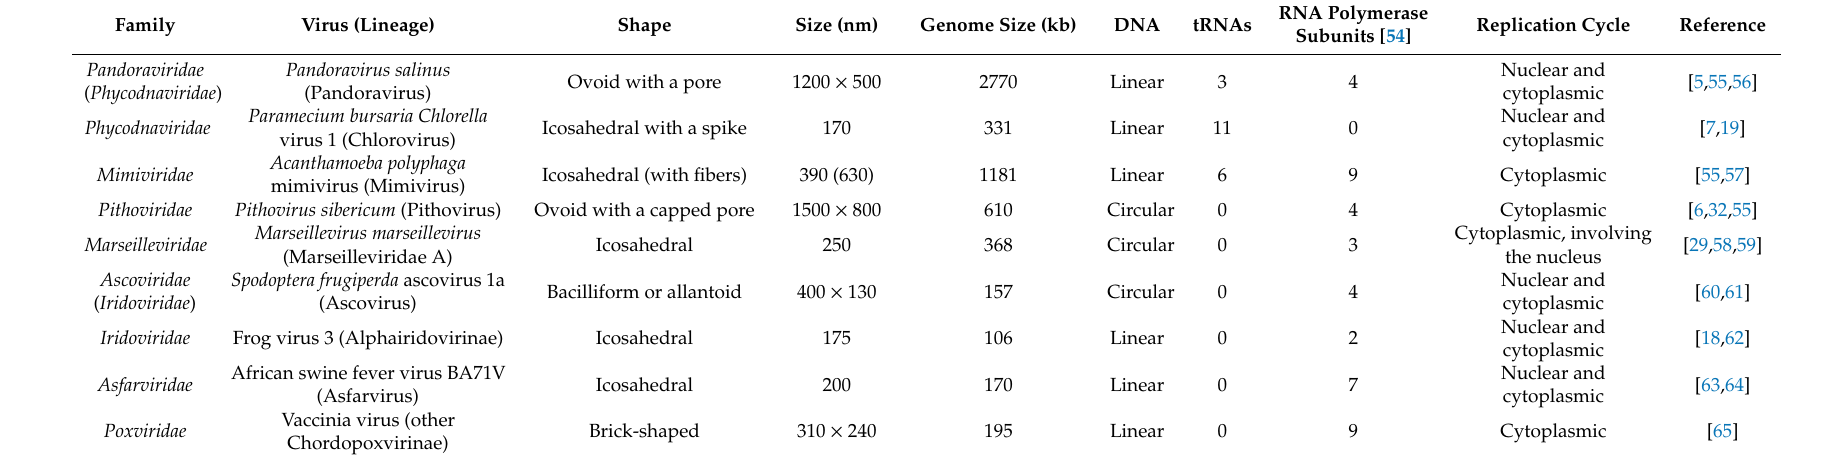
Table 1. A list of representative giant viruses and their morphological and genomic